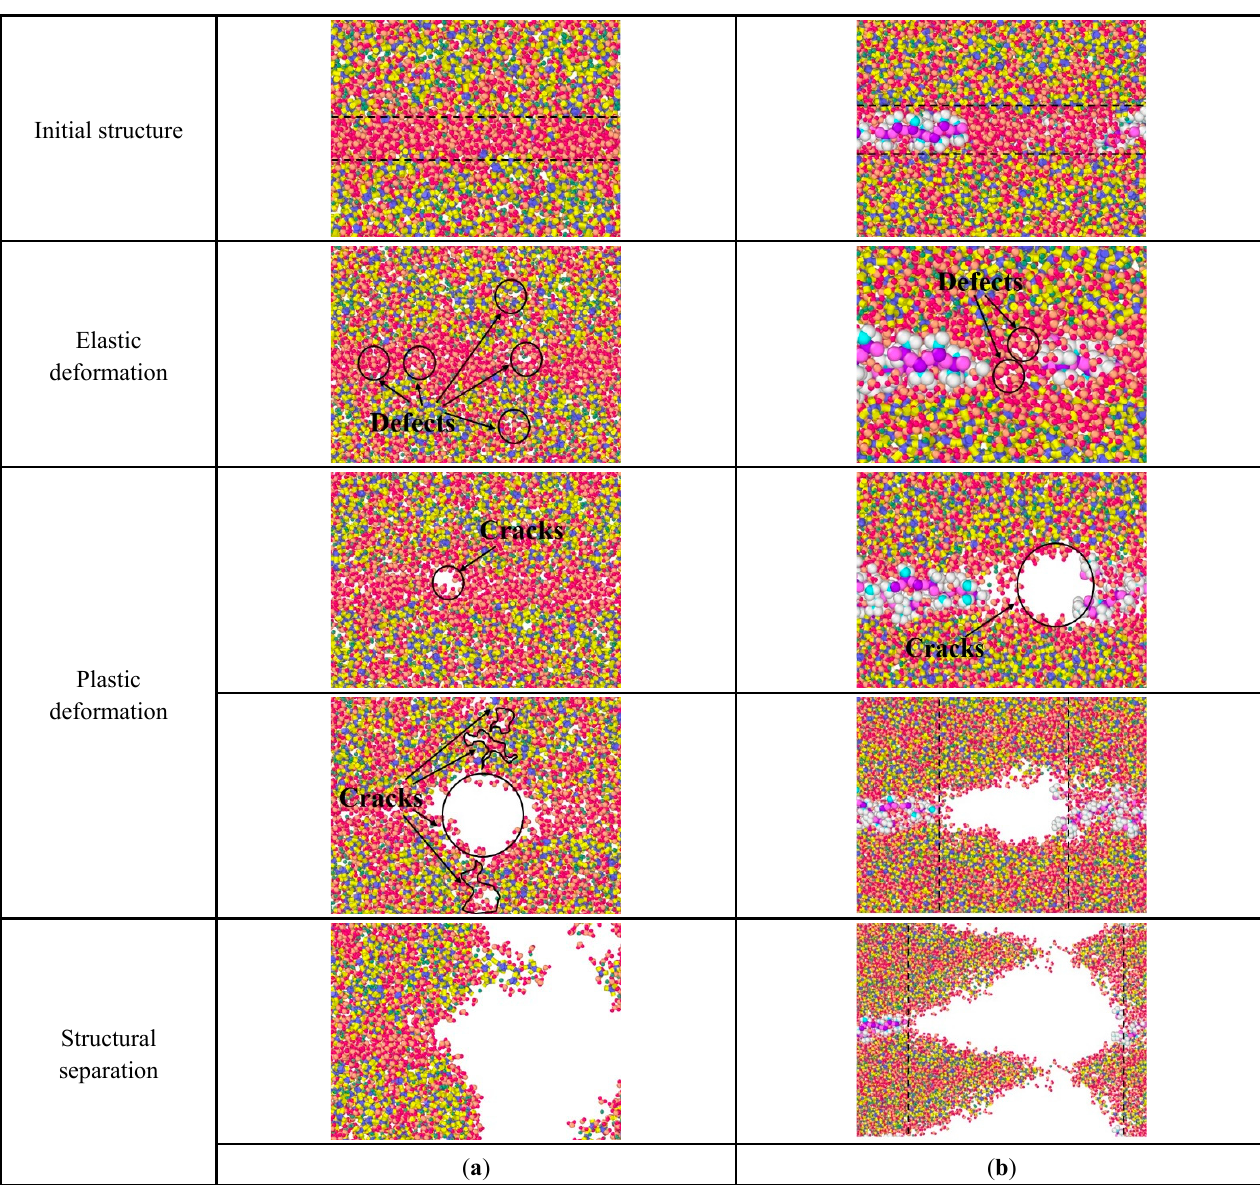
Figure 10. Structural changes of C-S-H stretched along the x-axis: ( a ) pure C-S-H; ( b ) PDMS- modified C-S-H.